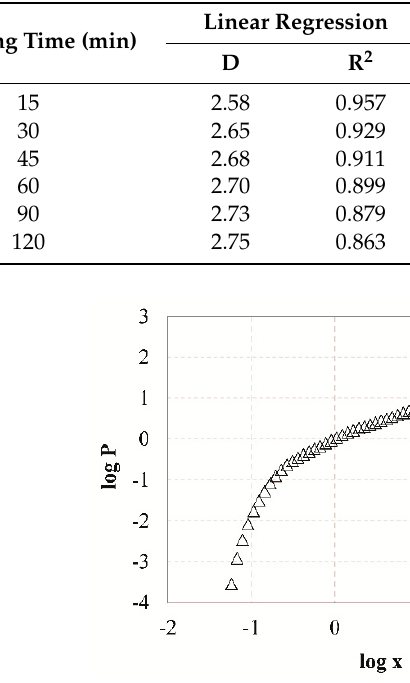
Figure 8. Log-log plot of particle size distribution of slag particles after 15 min of grinding.